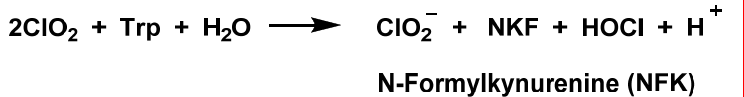
Figure 39. Proposed reaction mechanism for the attack of ClO 2 to tryptophane.